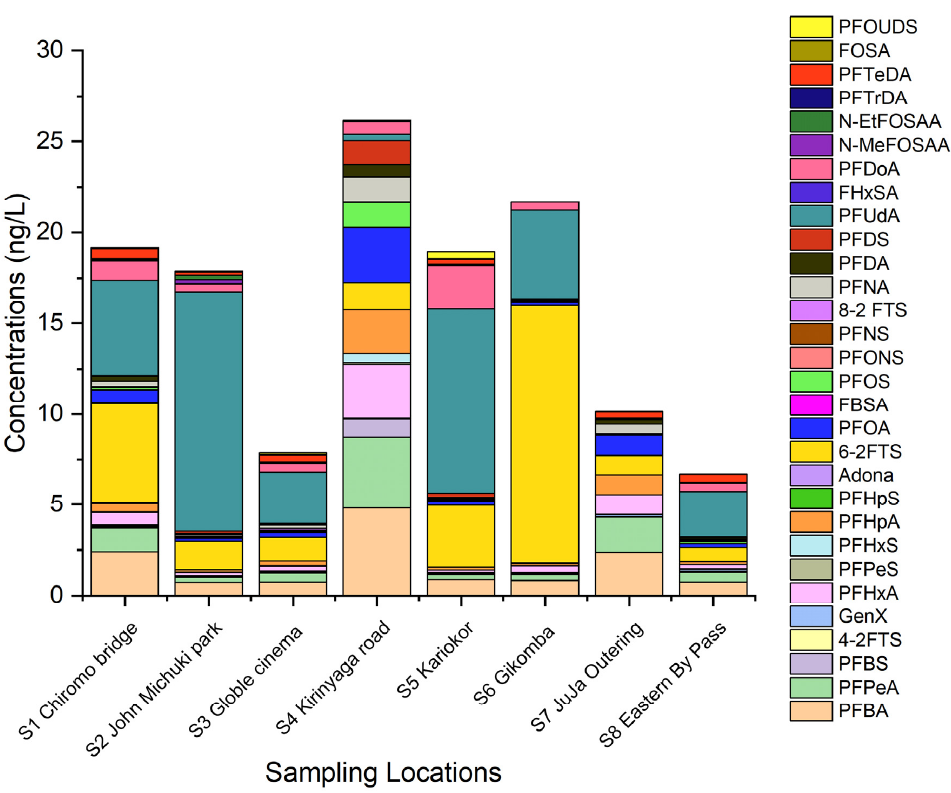
Figure 2. PFAS spatial distribution in Nairobi River water.